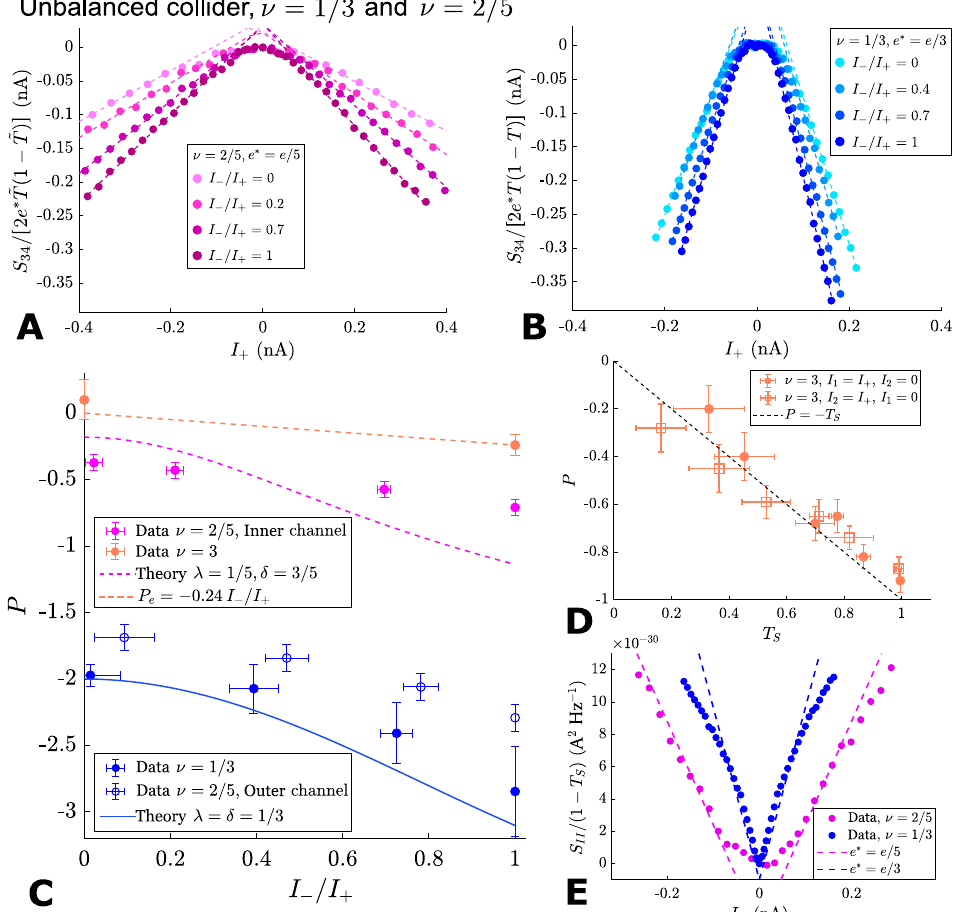
˜ T ð 1 − ˜ T Þ(cid:4) , with e (cid:2) ¼ e= 5 for the inner channel ¼ 0 . 24 . (d) P for I ¼ I T S − þ as a function of S in the integer